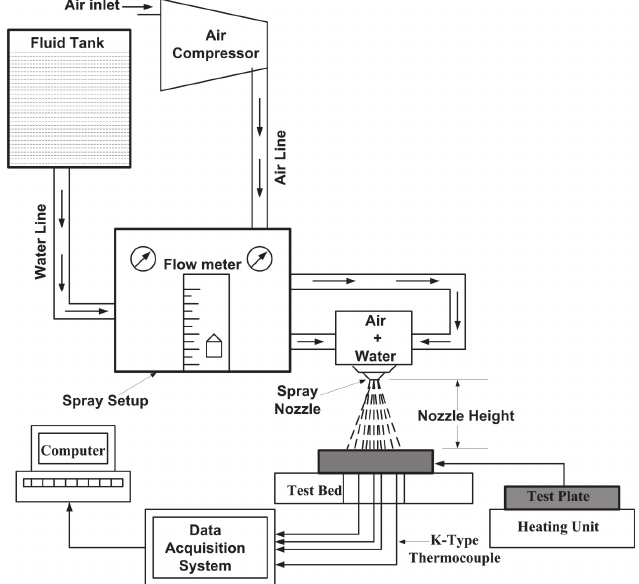
Fig. 1. Schematic of spray impingement cooling